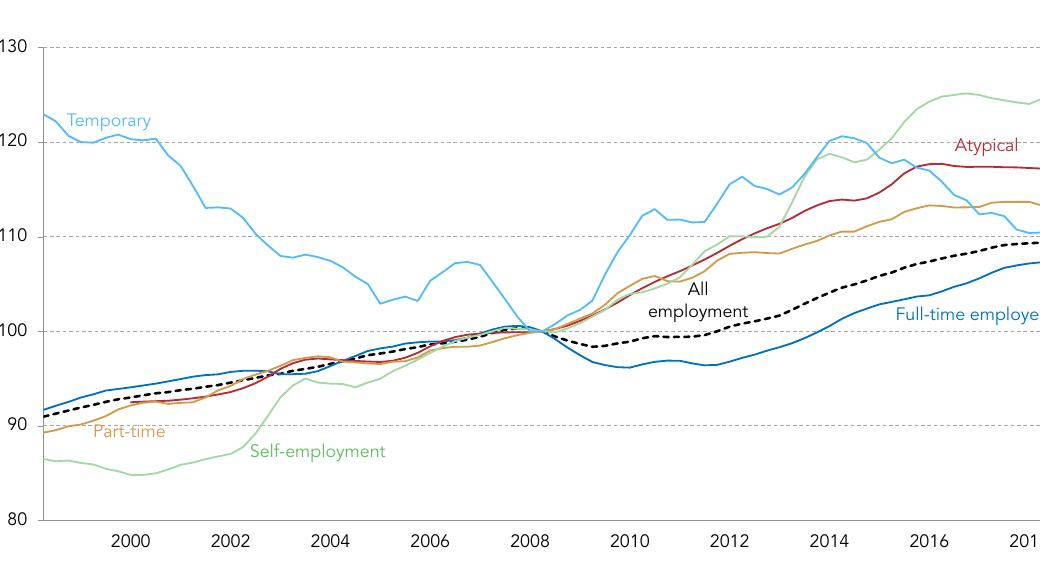
Figure 29: Atypical employment stopped growing in 2016 Employment by job-type (2008 = 100)